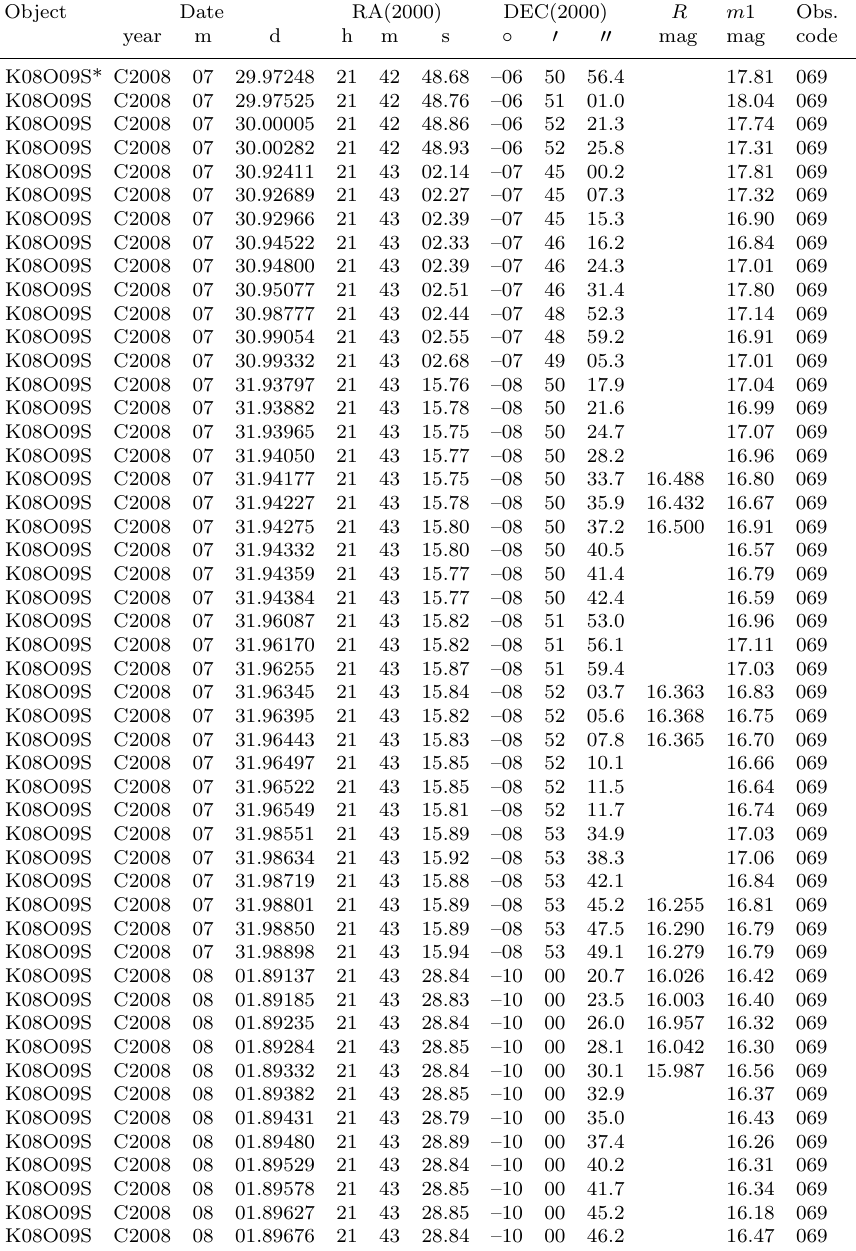
Table 6. Astrometric and photometric data for 2008 OS9 obtained at the Mol˙etai (152) and Baldone (069)